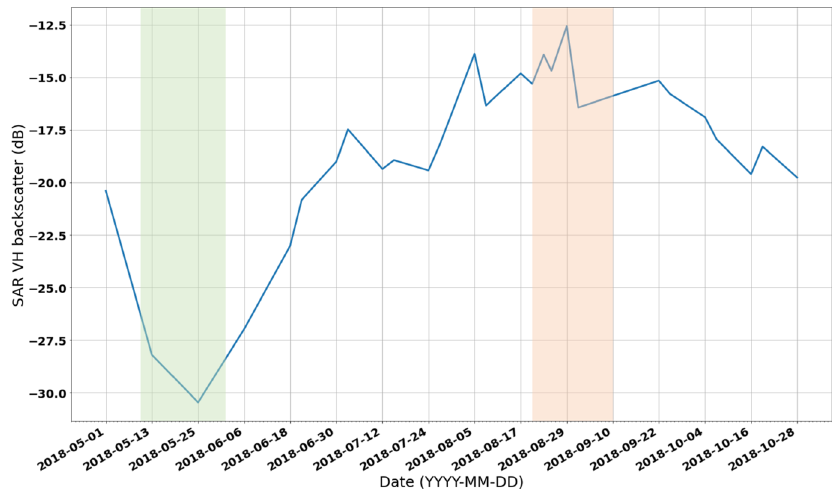
Figure 6. Temporal SAR backscatter profile (VH polarization) of sample rice fields. The green zone (10 May to 1 June) is the time window for the flooding signal and the orange zone (20 August to 10 September) for the peak signal.